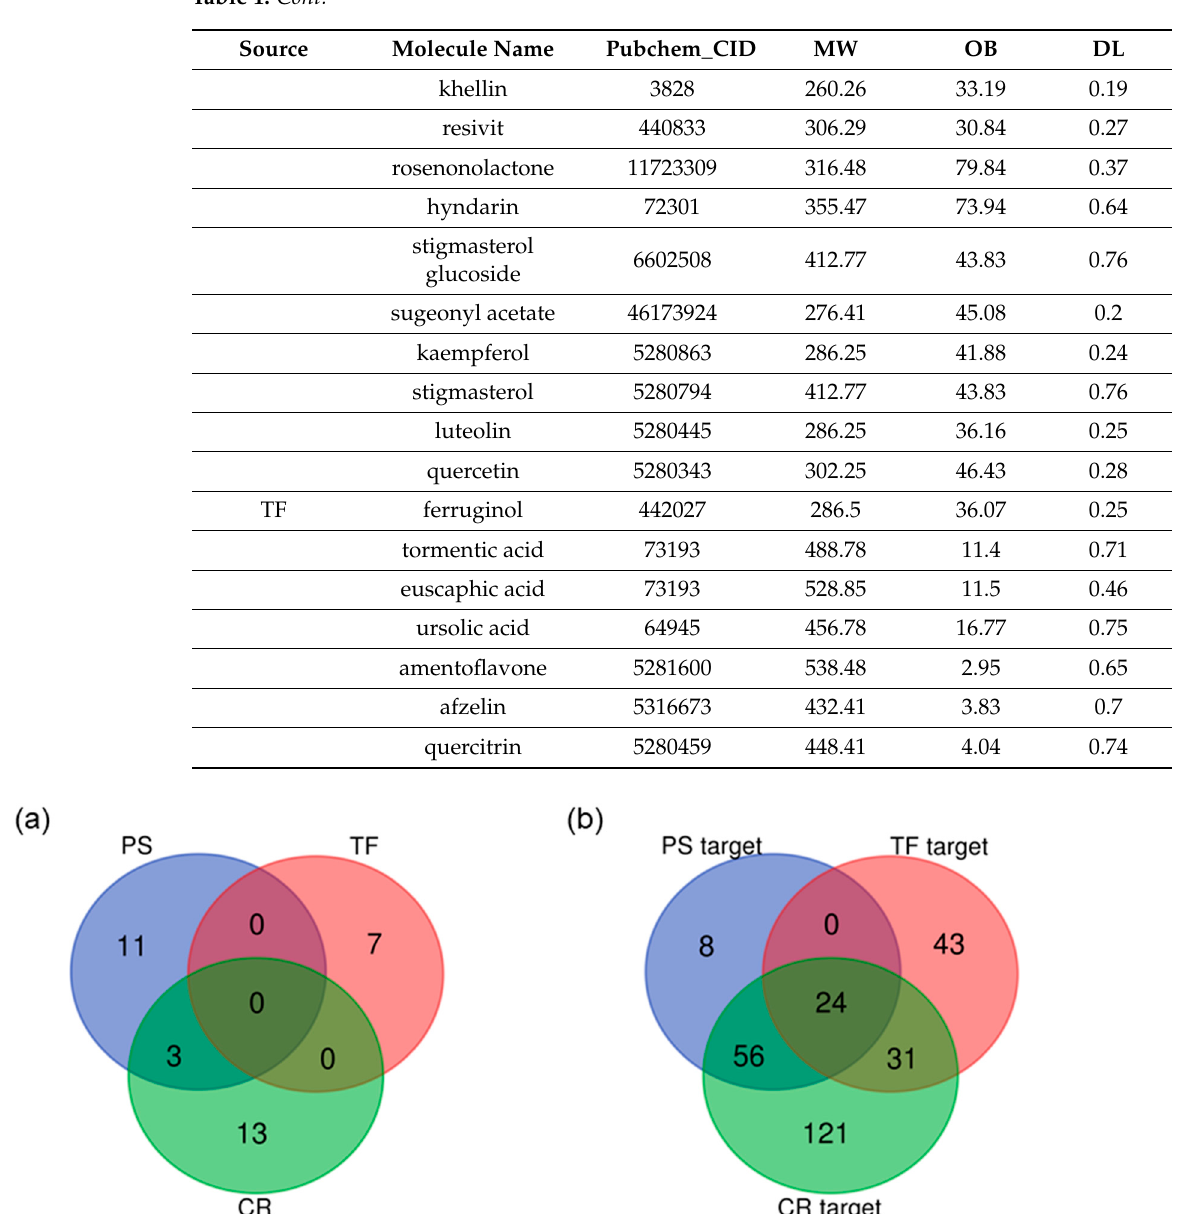
Table 1. List of potent active compounds from three herbs. PS— Pharbitis Semen, TF— Trogopterorum Faeces , and CR— Cyperi Rhizoma.